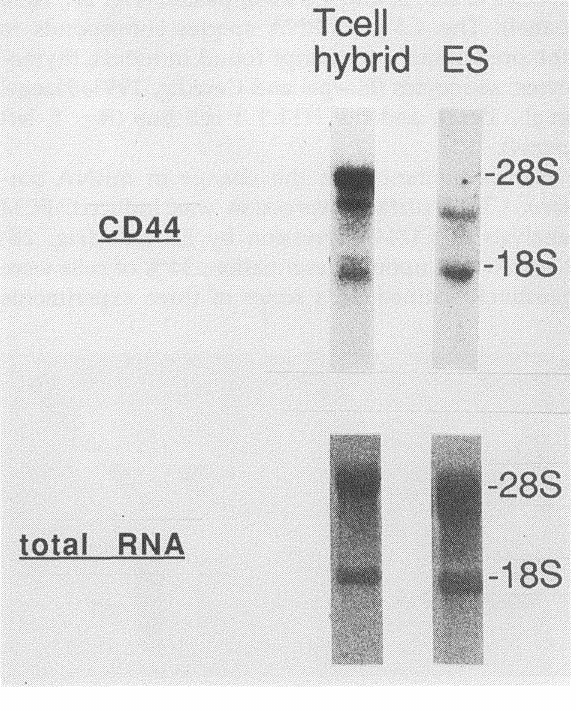
FIGURE 1. CD44 mRNAs in undifferentiated ES/D3 cells (right) compared to the Hl1.1 hybridoma T cells (left). Northern blot was hybridized to a standard CD44 cDNA probe (upper panel), after staining of total RNA with methylene blue (lower panel). The position of the ribosomal RNA bands of 28S (4.8 kb) and 18S (1.8 kb) is